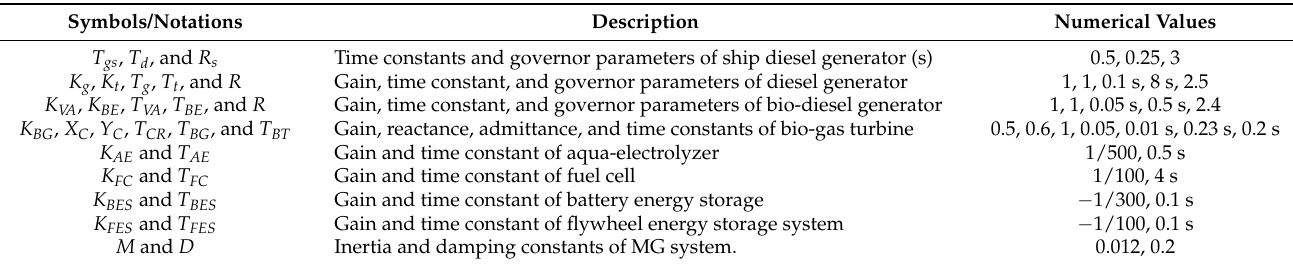
Table A1. System parametric values and